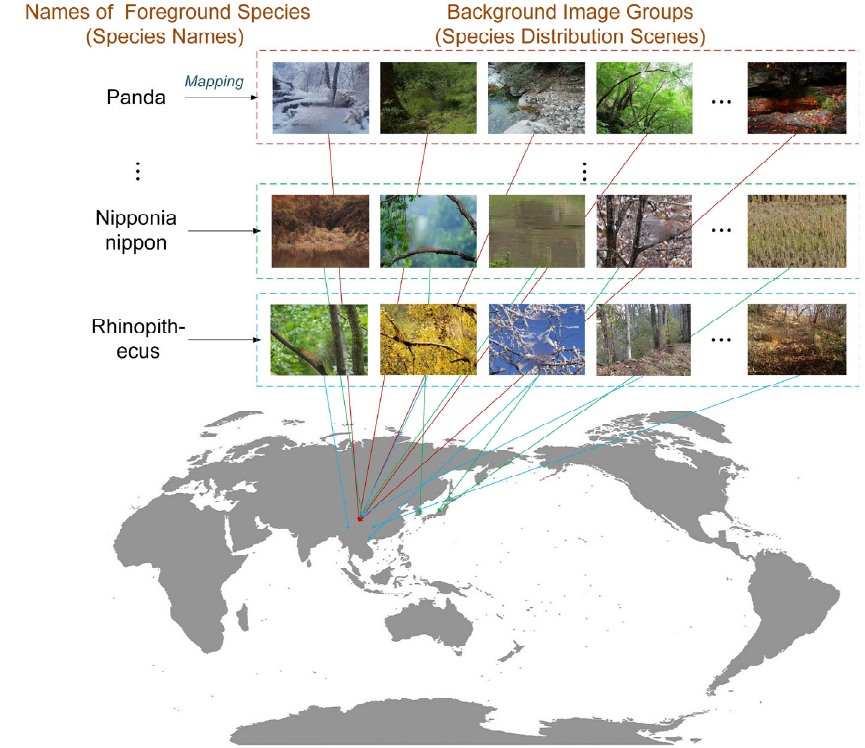
Figure 2. Architecture for the knowledge dictionary. Before data acquisition, background image groups are geotagged (GPS coordinates or GeoName). All the images are captured from an online data-sharing platform and pre-processed by the Saliency Network and Inpainting Network. Note that the number of downloaded pictures is variable in various species. After spatial sampling, the coordinates are not